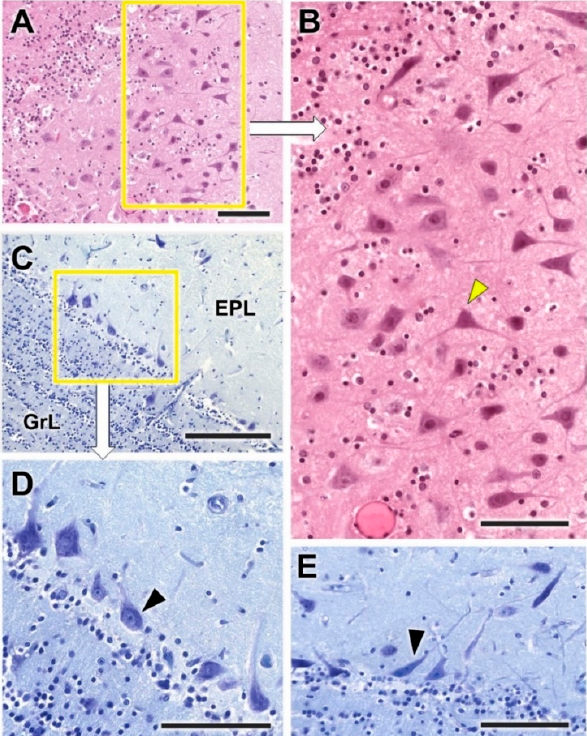
Figure 13. Histological study of the mitral cell layer of the olfactory bulb of the wolf. ( A ) Hematoxylin–eosin staining (box enlarged in ( B )) of a sagittal section of the mitral cell layer (MCL) showing typical mitral cells (arrowheads) with big soma and very well-defined dendritic projections. ( C – E ) Nissl staining of transverse sections of the MCL showing the diverse morphology of the mitral cell somas. Scale bars: 100 µm.